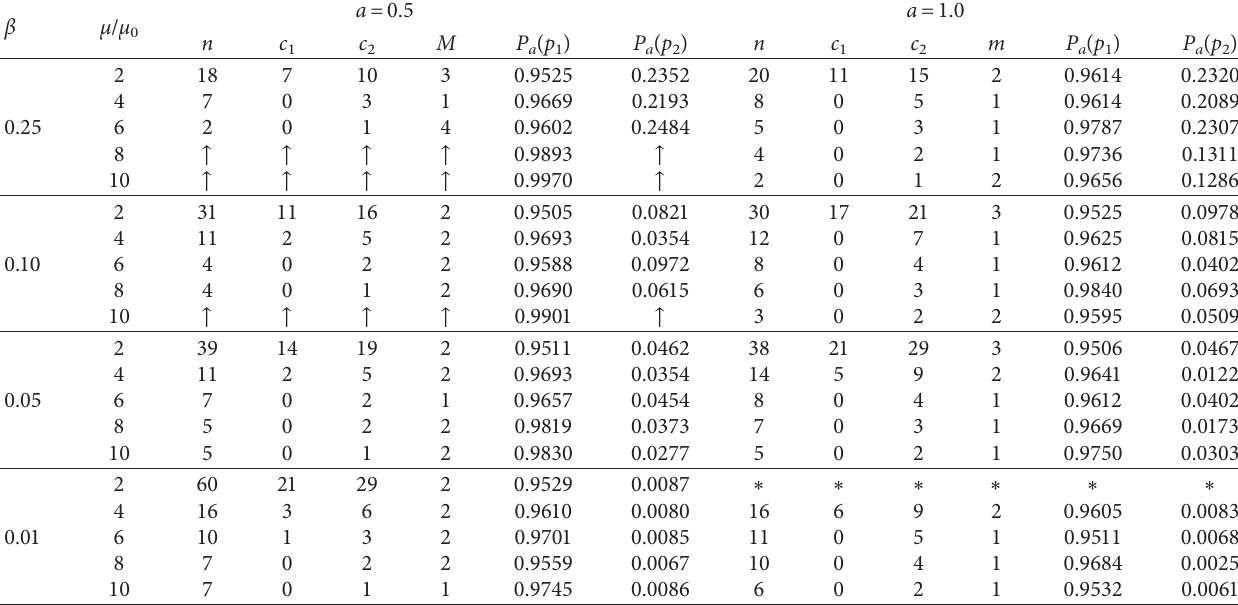
Table 3: Plan parameters of modified MDS sampling plan for Birnbaum-Saunders distribution with ω � 1.5.